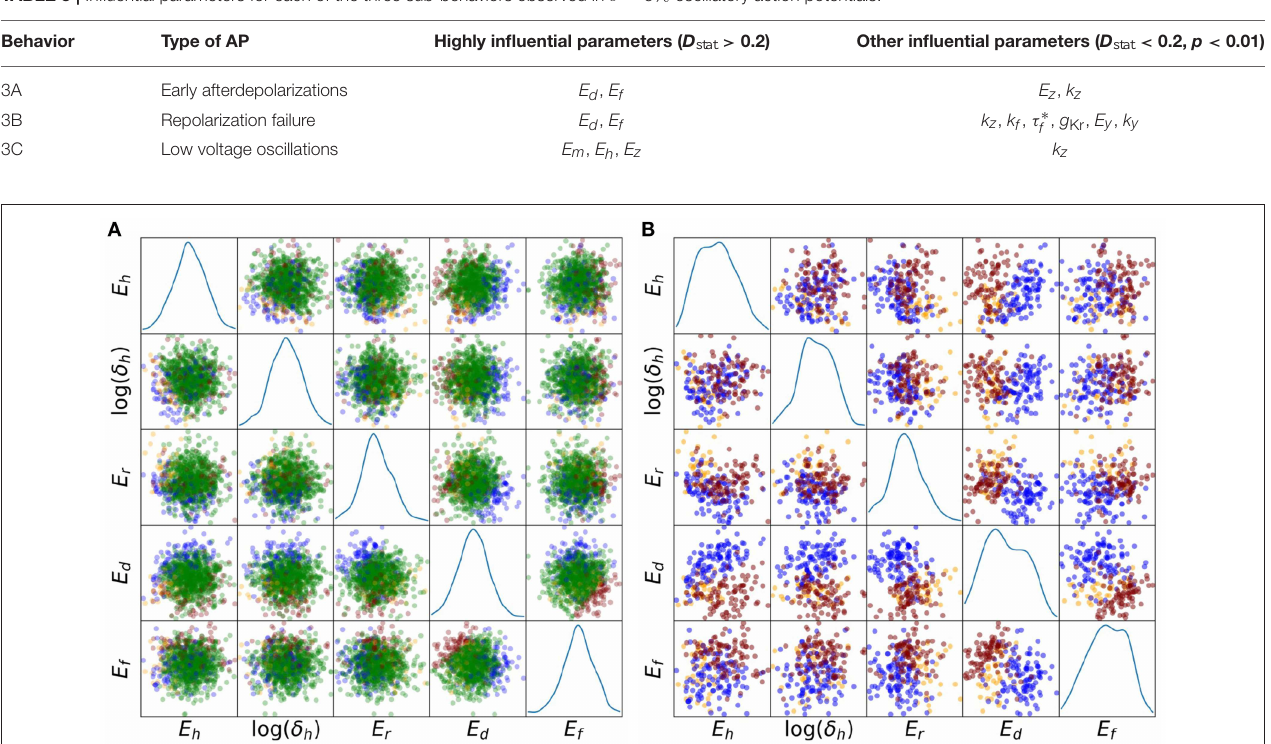
TABLE 3 | Influential parameters for each of the three sub-behaviors observed in ˆ σ = 5 % oscillatory action potentials. Behavior Type of AP Highly influential parameters ( D stat > 0.2)